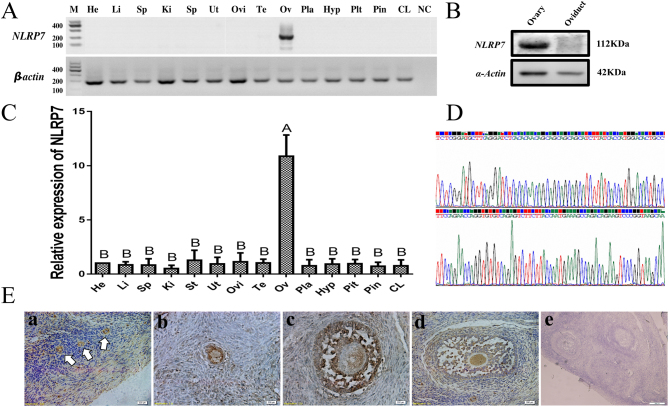
Tissue distribution and intraovarian localization of ovine NLRP7.(A) RT-PCR analysis of NLRP7 mRNA transcripts in multiple ovine tissues. Samples of heart (He), liver (Li), spleen (Sp), kidney (Ki), stomach (St), uterus (Ut), oviduct (Ovi), testis (Te), ovary (Ov), placenta (Pla), hypothalamus (Hyp), pituitary (Pit), pineal gland (Pin) and corpus luteum (CL) were subjected to RT-PCR. M, Marker; NC, no PCR substrate as negative control. β-actin was used as a loading control. (B) Western blot of extracts obtained from sheep ovary and a control tissue (oviduct, randomly selected). Molecular masses (kDa) are indicated on the right. α-actin was used as an internal control.(C) Distribution of NLRP7 mRNA in different ovine tissues demonstrated by quantitative real-time RT-PCR using β-actin and GAPDH as the reference genes; Experiments were repeated three times (n = 3) independently. Results have been normalized to the abundance in the heart (calibrator sample, randomly selected) and expressed as the mean ± s.e.m. Bars with different capital superscripts are significantly different (P < 0.01). (D) Sequencing results of NLRP7 RT-PCR products.(E) Immunohistochemical localization of NLRP7 protein in the ovary sections. primordial follicles (a), primary follicle (b) and antral follicles (c, d,), e, negative control. Arrows are (a) indicators of primordial follicle. Scale bar = 200 µm.